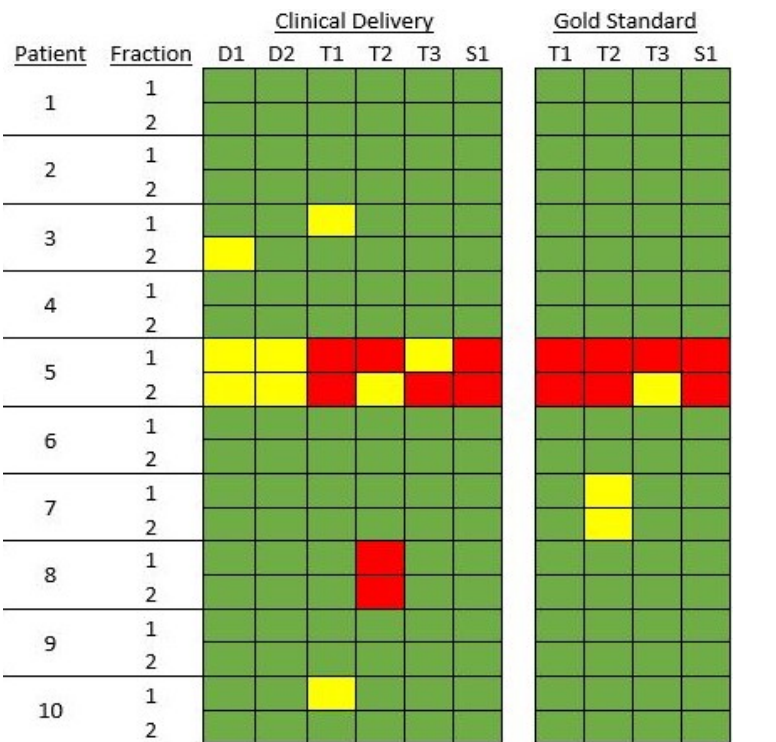
Figure 3. Heat map of plan outcomes. Green boxes signify that the plan met the specified constraints. Yellow boxes signify that the plan was within the ‘Acceptable Variation’ range for one or both constraints. Red boxes signify the plan missed one or both specified constraints.